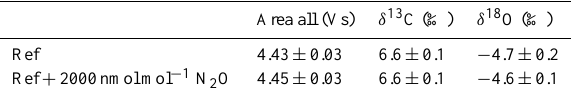
Table 1. Peak area and isotopic composition of the reference gas, and an aliquot of the reference gas that was spiked with 2000nmolmol − 1 N 2